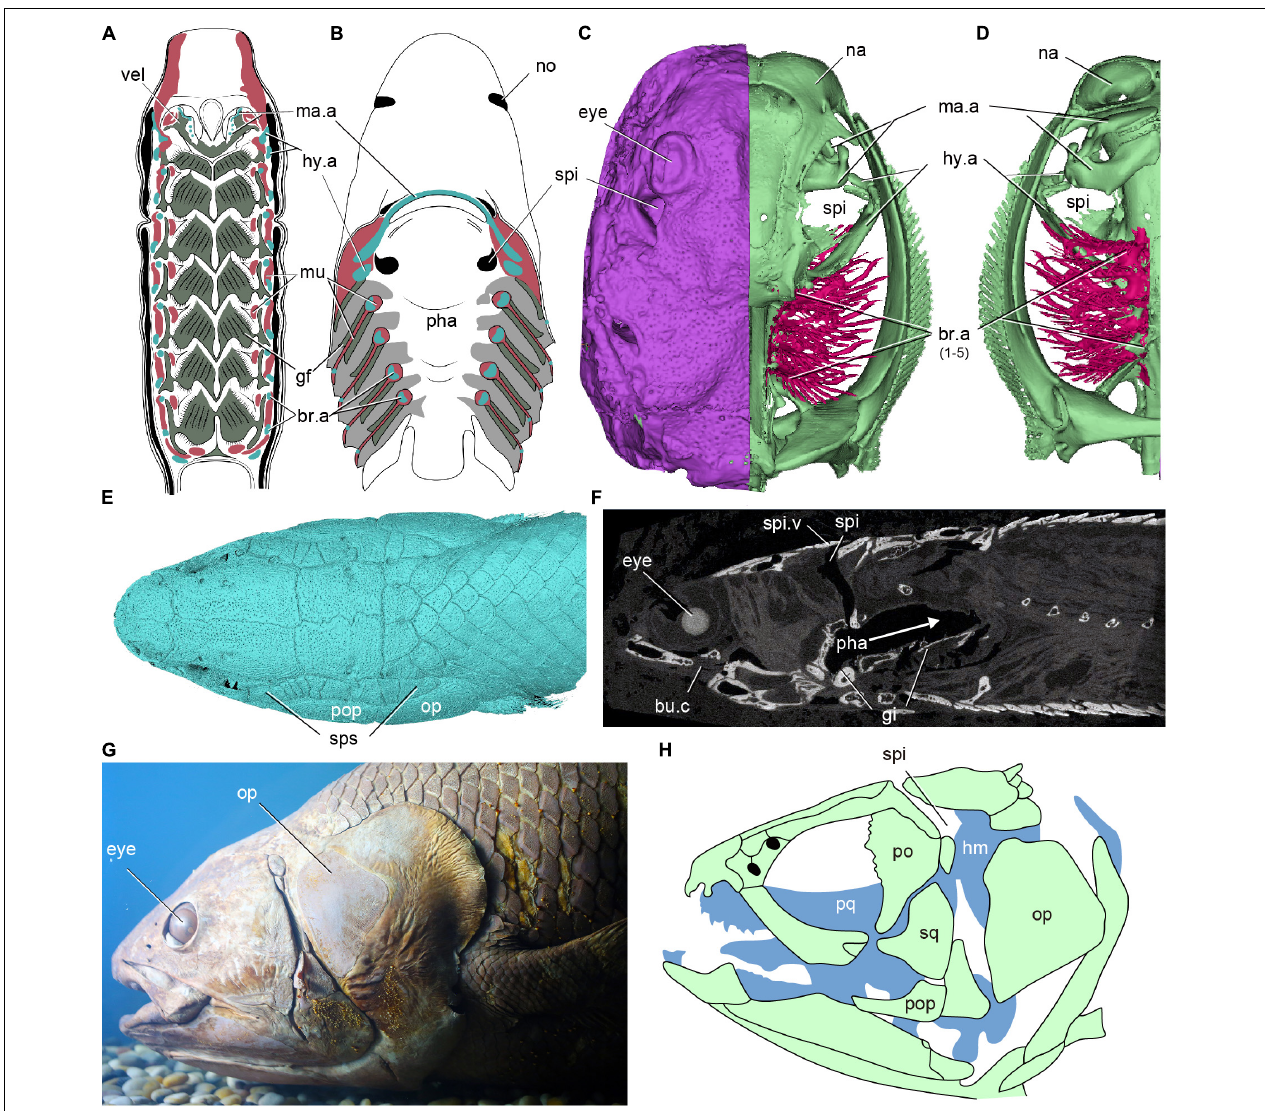
FIGURE 1 | The distribution of spiracles in extant fishes. (A) Dorsal half of a horizontally sectioned lamprey ( Petromyzon marinus ) ammocoete larva, in ventral view, showing no branchial chambers between mandibular (velum) and hyoid arch. (B) Dorsal half of a horizontally sectioned dogfish ( Squalus acanthias ), in ventral view, showing a ventral opening of the spiracular tube on the palate between mandibular (jaw) and hyoid arch. (C,D) The 3D reconstruction of a modern ray, showing a spiracle between the mandibular and hyoid arches, (C) in dorsal view, panel (D) in ventral view. (E,F) 3D reconstruction (E) and a sagittal Micro CT image (F) of a polypterid fish Erpetoichthys calabaricus, showing the path (arrows) of air through the spiracles to the buccopharyngeal chamber and lungs. (G,H) Photo (G) and skeleton (H) of the head of an African coelacanth Latimeria chalumnae , in lateral view, showing a non-functional internal spiracular cavity but no external opening. [ (A) redraw from Gaskell (1908), (B) redraw from Mallatt (1984), (G) photo from the specimen IVPP OP392, (H) redraw from Forey (1998)] br.a, branchial arch; bu.c, buccal chamber; gi, gill; gf, gill filaments; hy.a, hyoid arch; hm, hyomandubular; ma.a, mandibular arch; mu, muscle; na, nasal sacs; no, nostril; op, opercle; pha, pharynx; po, postorbital; pop, preopercle; pq, palatoquadrate; spi, spiracle; spi.v, spiracle valve; sps, spiracular series; vel,